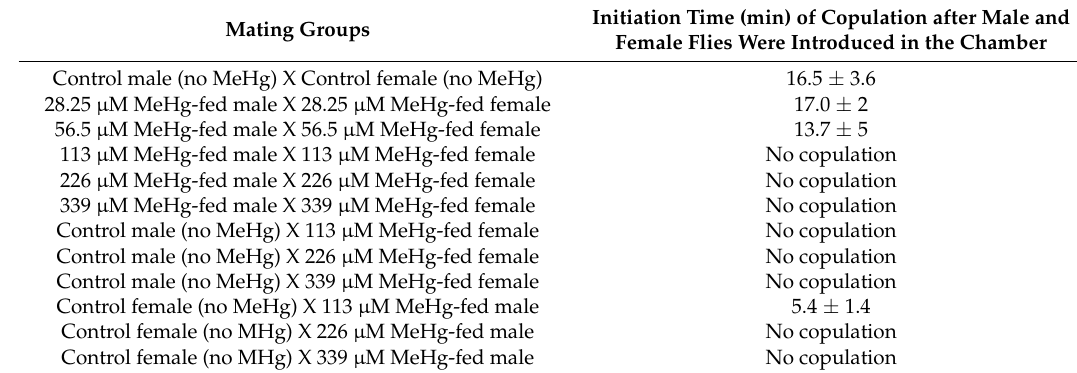
Table 1. Time taken by flies to copulate in various groups. Initiation Time (min) of Copulation after Male and Mating Groups Female Flies Were Introduced in the